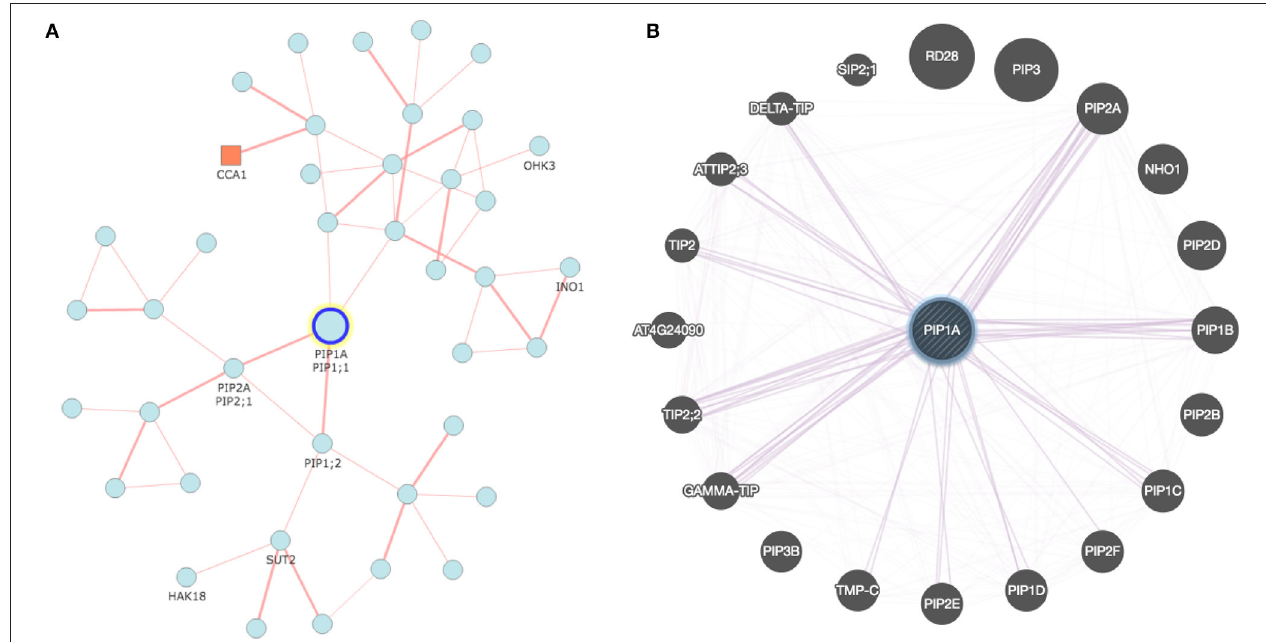
FIGURE 1 | Co-expression network developed for rice and Arabidopsis aquaporin genes: (A) Network analyzed with RiceFREND tool (http://ricefrend.dna.affrc.go.jp) showing interdependency of PIP1-1, PIP1-2, and PIP2-1 in rice; and (B) Network of Arabidopsis visualized with GENEMANIA tool (http://genemania.org) showing interaction of PIP1A with PIP2 and other genes. Network for all rice AQPs at the third hierarchical level is provided in Supplementary Data 2.